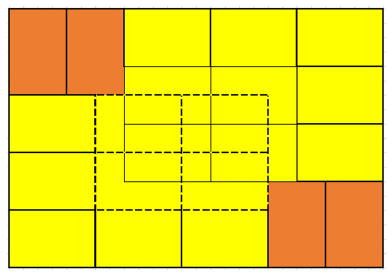
Figure 5. Horizontal multi-object overlap.